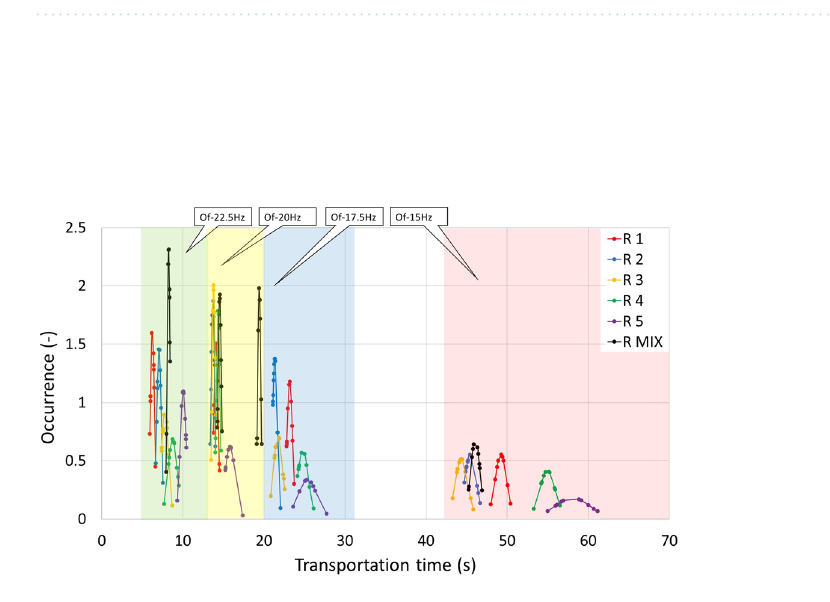
Figure 22. The transport time of the particles in the transport of the rods depends on the different frequencies of the transport